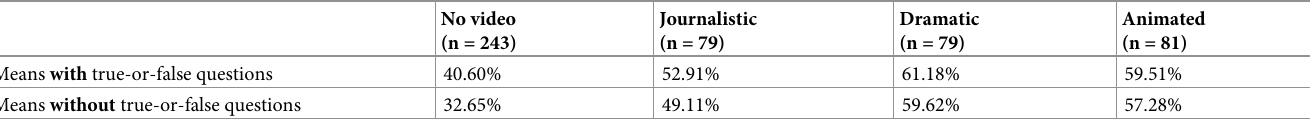
Table 5. Comparison of knowledge acquisition when excluding true-or-false